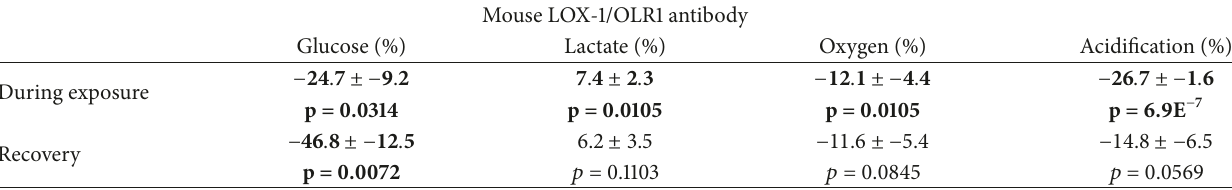
Table 6: Metabolic effects of mouse LOX-1/OLR1 antibody exposure on macrophages. Mean peak MAMP height changes and standard errors for each experimental condition during exposure and recovery are shown. All 𝑝 values are calculated based on peak height versus 10min average basal value prior to exposure. Terms in bold are representative of 𝑝 < 0.05 , indicating statistical significance.